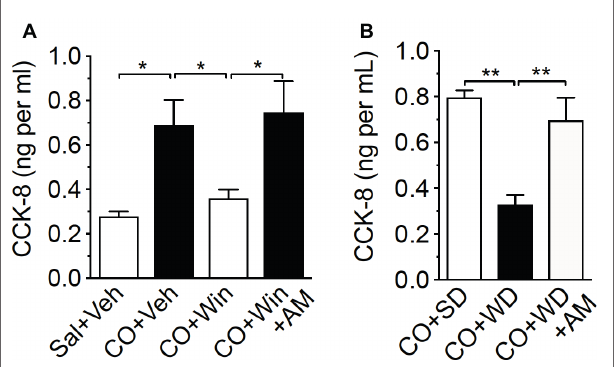
FIGURE 3 | Exogenous or endogenous activation of peripheral CB1Rs inhibits fat-induced CCK release. Compared to control [0.5 ml saline (Sal) by oral gavage and vehicle (Veh) by IP injection], corn oil (CO; 0.5 ml by oral gavage) increased levels of CCK-8 in plasma of lean mice fed a low-fat no- sugar standard diet (SD), an effect blocked by the CB 1 R agonist, WIN 55,212-2 (WIN, IP 3 mg per kg 30 min before CO) (A) . The effects of WIN were inhibited by co-administration with the peripherally-restricted CB 1 R antagonist, AM6545 (AM; 10 mg per kg 30 min before CO). When compared to control SD mice (CO + SD), CO failed to elicit changes in levels of CCK-8 in plasma in mice fed western diet (WD) for 60 days, and inhibition of peripheral CB 1 Rs with AM6545 normalized levels of CCK-8 to those found in SD CO controls (B) . Data expressed as means ± S.E.M. Analyzed by one-way ANOVA with post hoc Newman-Keuls multiple comparison test. n = 3–5 per condition, * p < 0.05, ** p < 0.01.